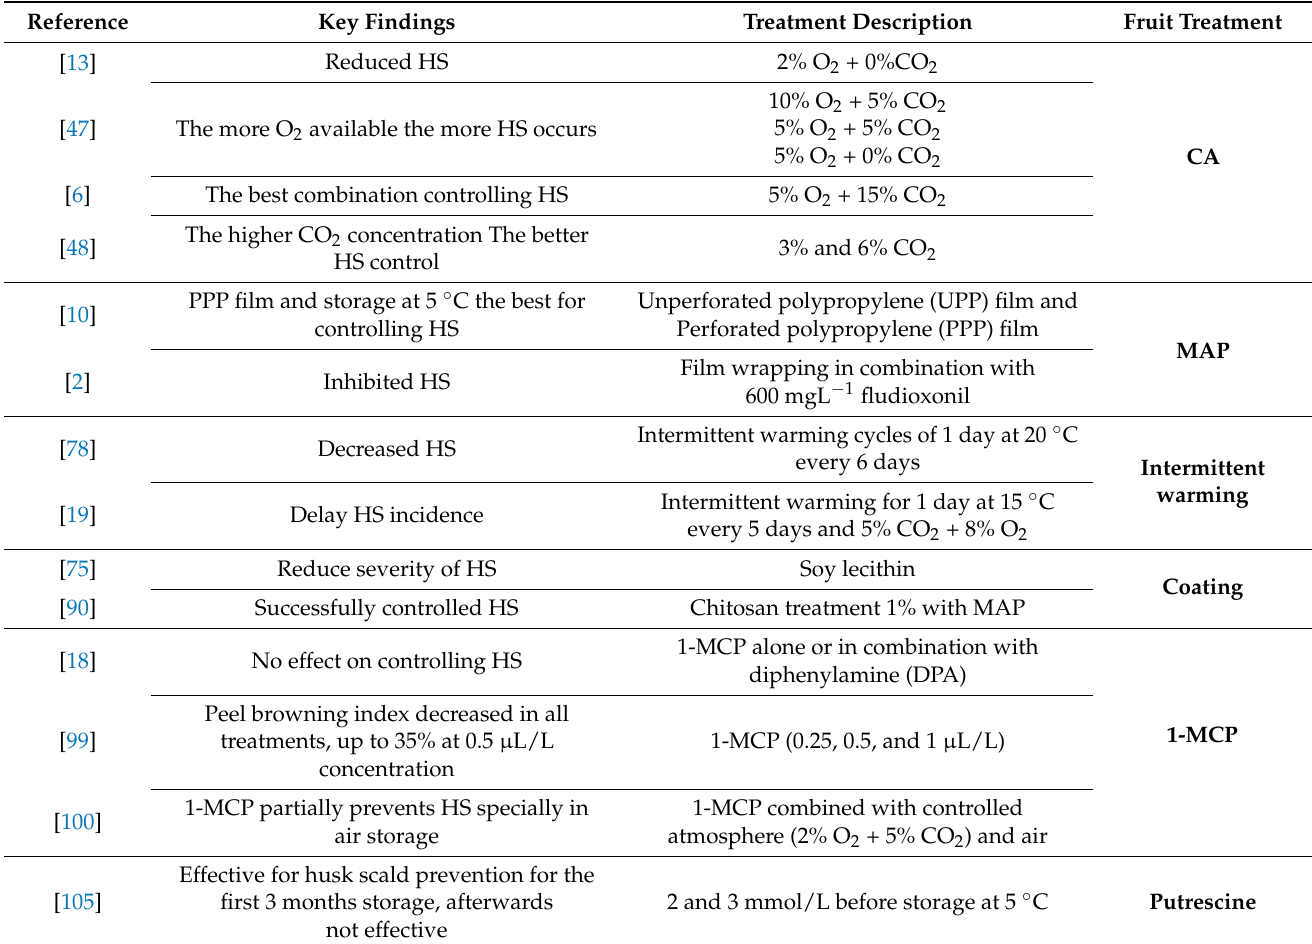
Table 2. Summary of postharvest treatments applied to prevent husk scald (HS) in pomegranate fruit during